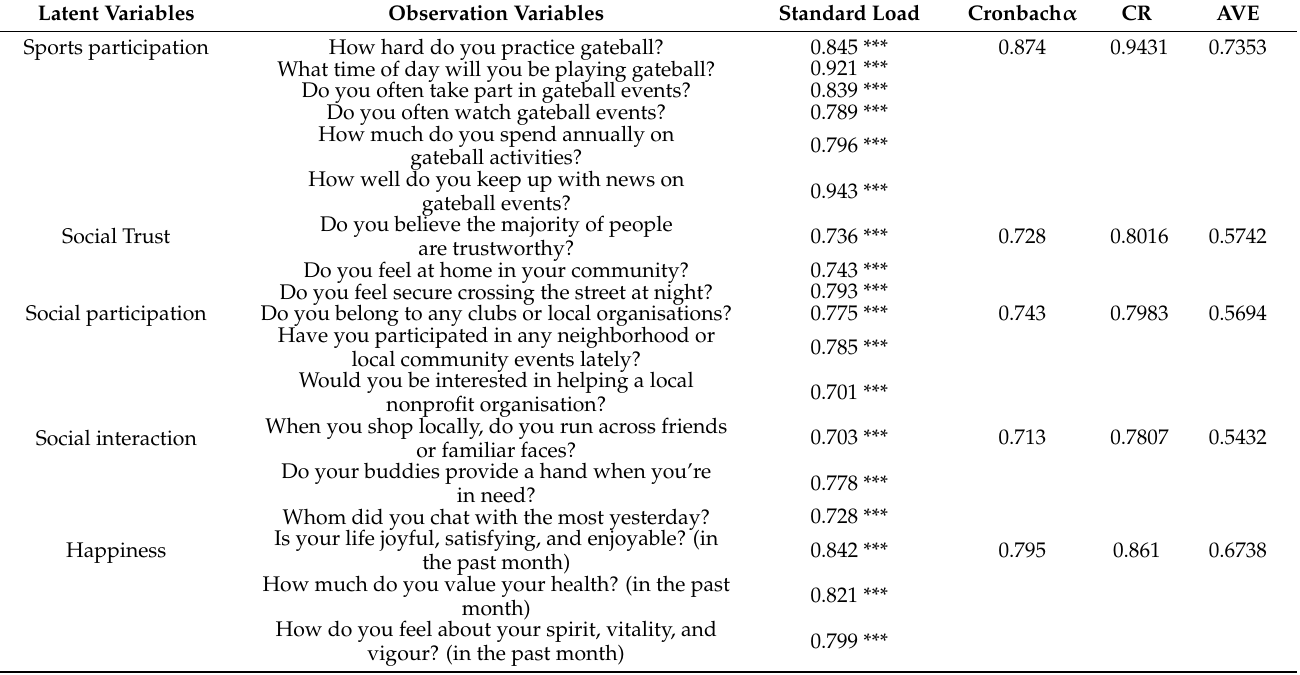
Table 2. Table of confidence validity